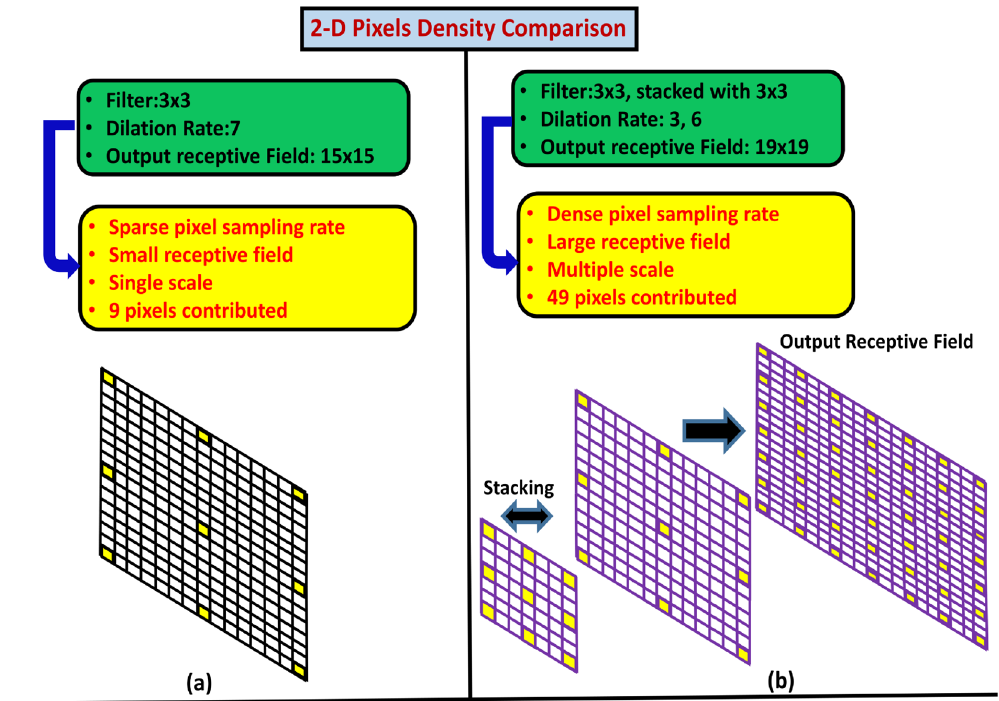
Figure 2. A comparison between SDC and DSDC in terms of pixels density and relevant contextual features, ( a ) SDC with dilation rate (7) results in smaller receptive field. ( b ) Stacking a dilated layer with smaller dilation rate (3) with larger dilation rate (6) make a denser sampling rate with larger receptive